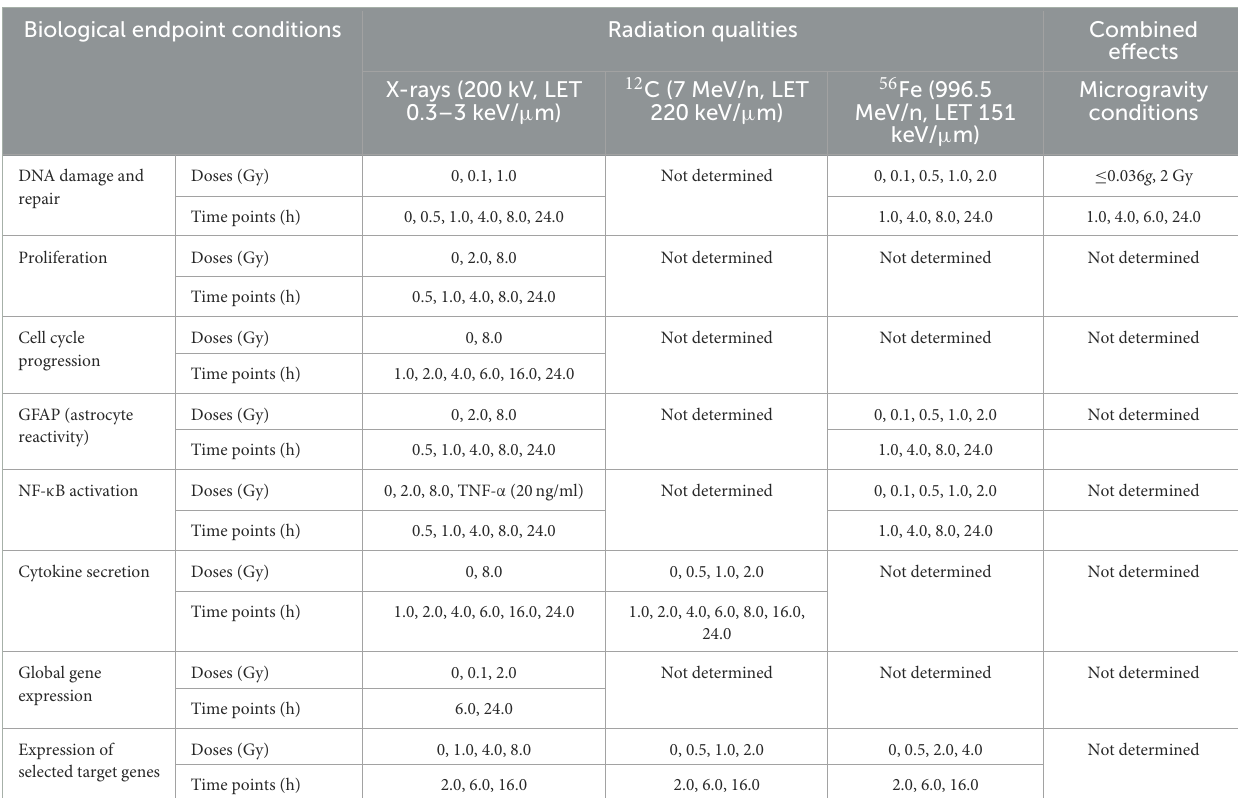
TABLE 1 Overview of the experiments: radiation quality, doses, time points, biological endpoints. Biological endpoint